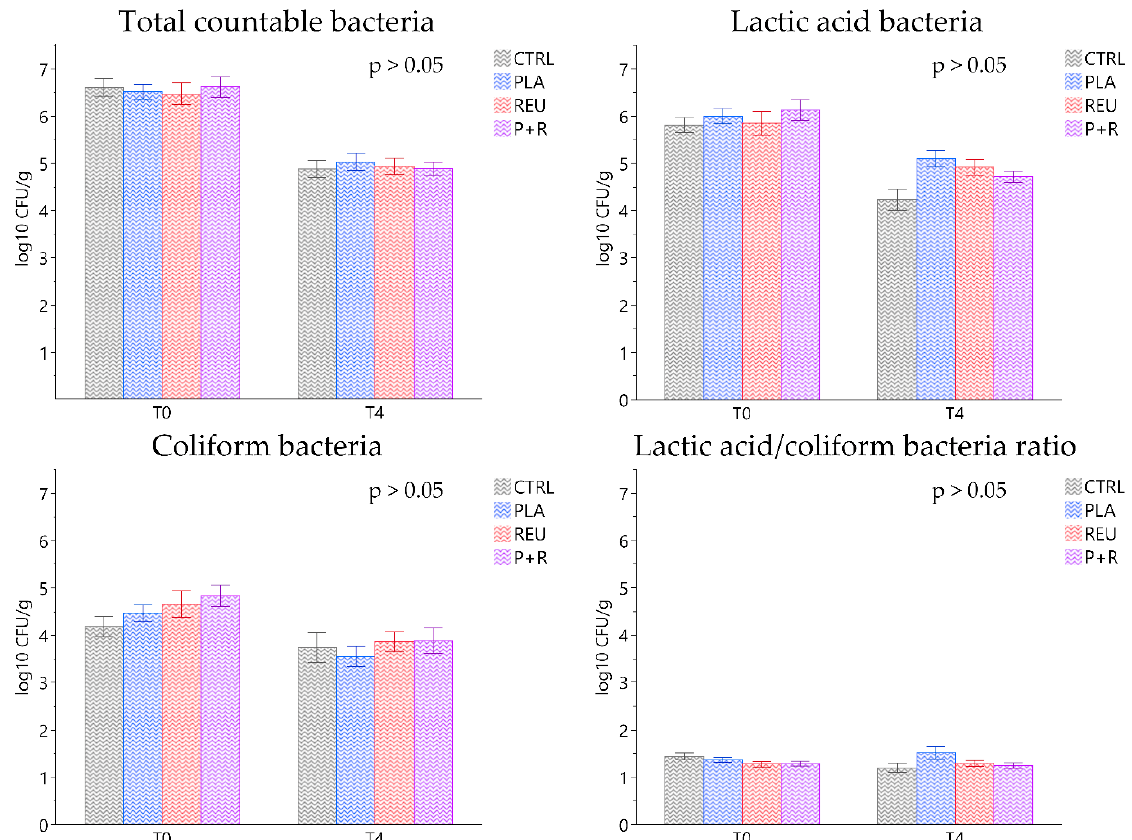
Figure 6. Faecal colonies of the principal bacterial groups (total countable bacteria, lactic acid bacteria, coliform bacteria and lactic acid/coliform ratio) for the control (CTRL) and treatment groups (PLA, REU and P+R) measured at the beginning (T0) and after 28 days of the trial (T4). Data are expressed as least square means (LSMEANS) and standard errors (SE). CTRL: control group; PLA: treatment group supplemented with 2 × 10 8 CFU/g of L. plantarum ; REU: treatment group supplemented with 2 × 10 8 CFU/g of L. reuteri; P+R: treatment group supplemented with 2 × 10 8 CFU/g of L. plantarum and L. reuteri (1:1, w / w ).